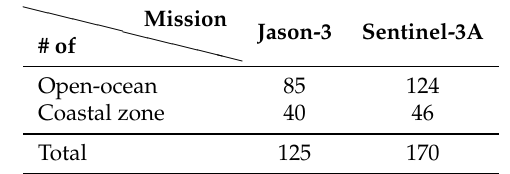
Table 2. Number of the selected total, open-ocean and coastal buoys for the J3 and S3A missions.